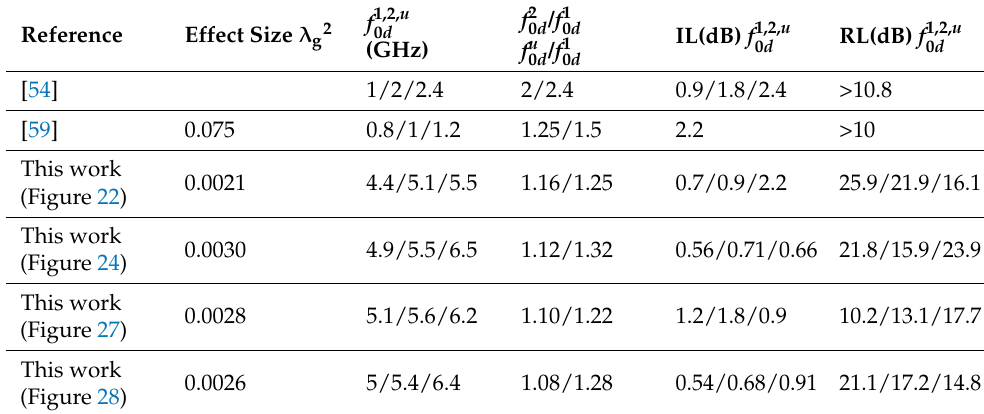
Table 5. Comparison between different models of